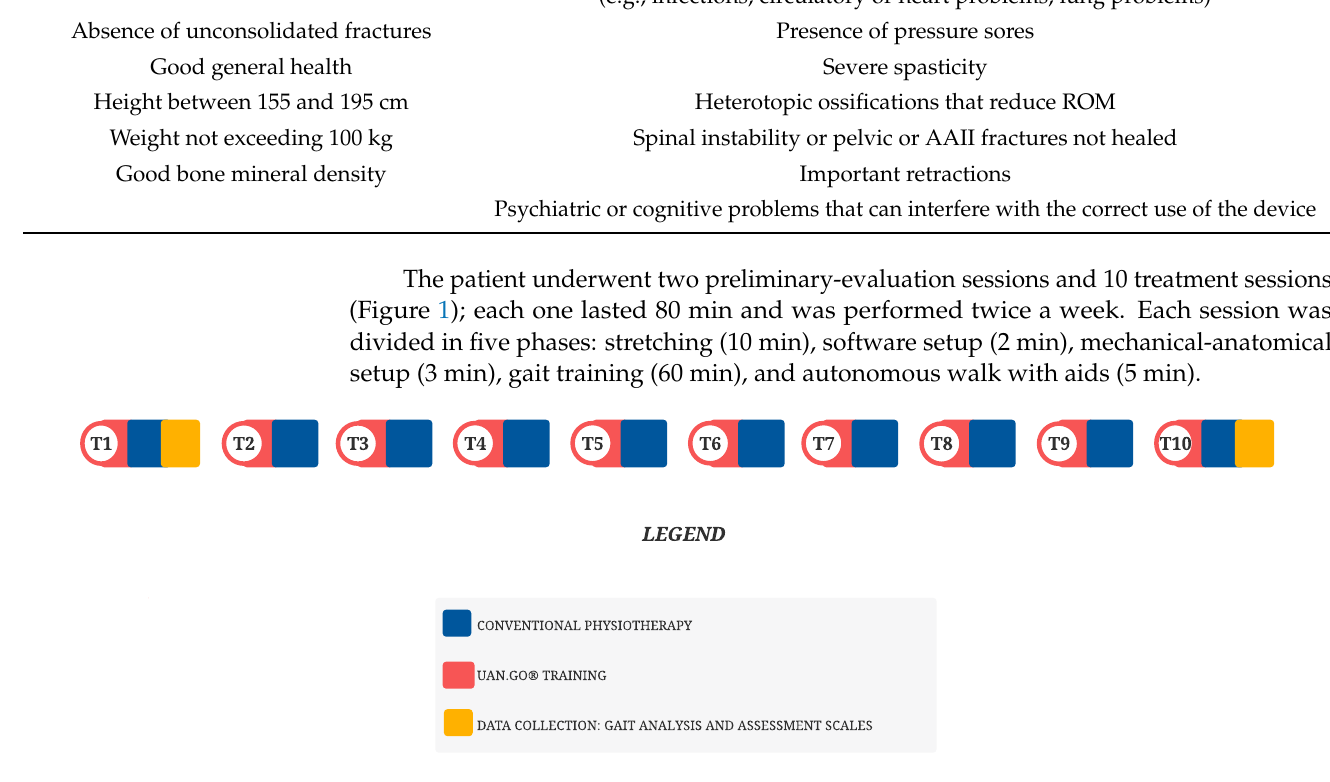
Figure 1. Timeline of RAGT/physiotherapy intervention; the patient was initially assessed for eligibility to the study (T1) with SARA score, Berg balance scale, 6MWT, Likert scale. A parallel program of ten session of flexibility exercise and RAGT training was than performed by the same physiotherapist. The last session (T10) was dedicated to the final evaluation.